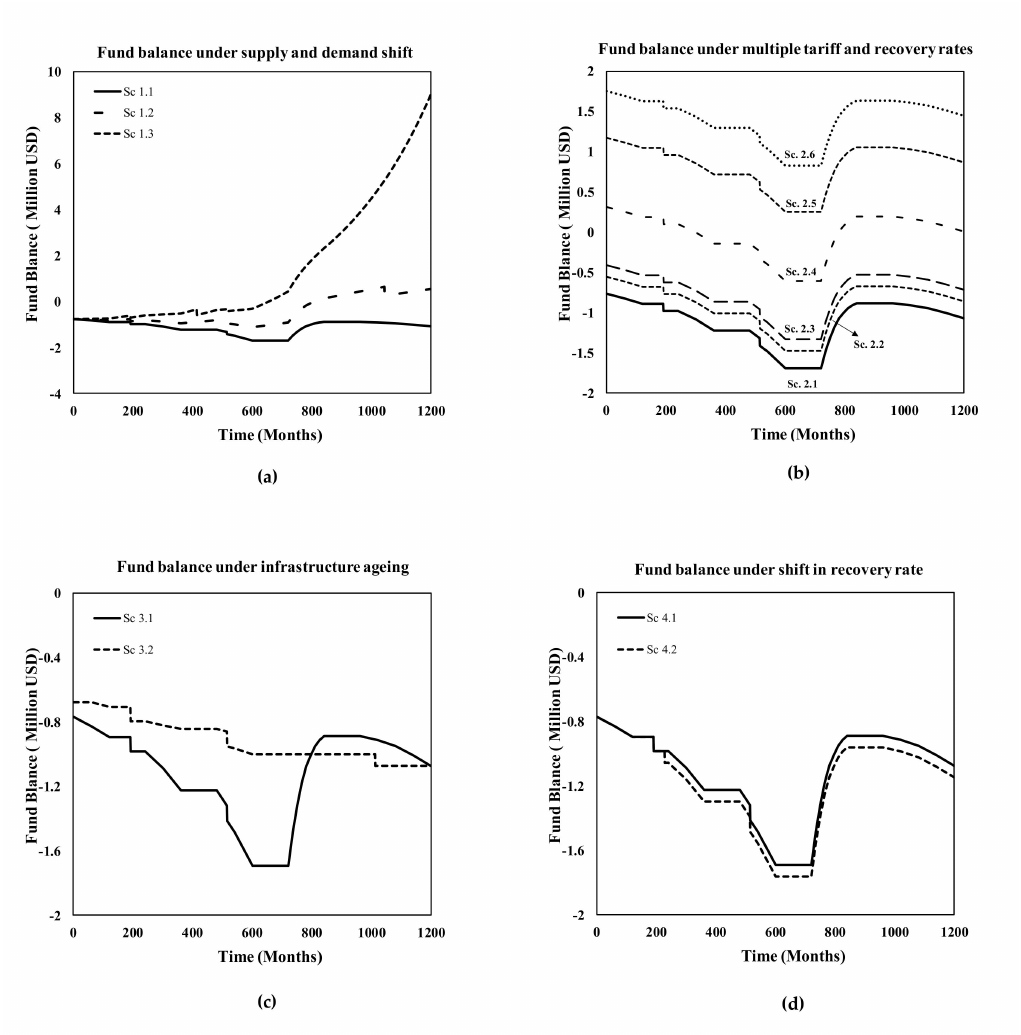
Figure 6. Sensitivity analysis results for Formal system fund balance under ( a ) demand supply changes, ( b ) multiple tari ff and recovery rates, ( c ) infrastructure ageing, and ( d ) changes in tari ff recovery under demand shift to